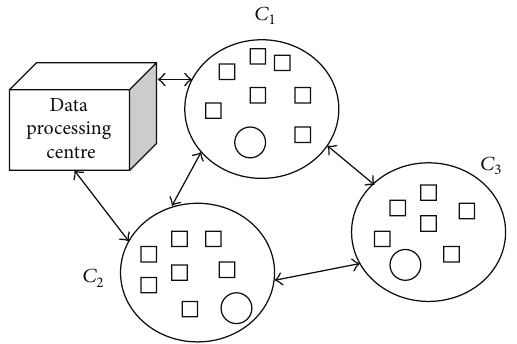
Figure 2: Adaptive node energy